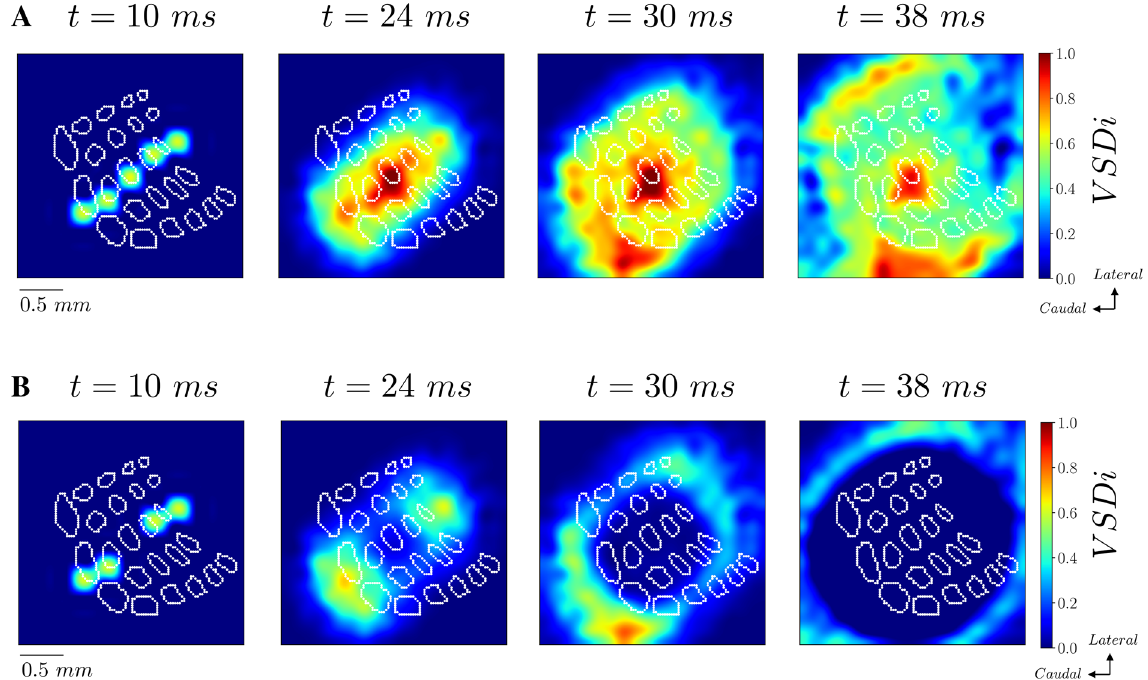
Figure 8. Model prediction of cortical activity evoked by stimulation of the entire C row. (A) VSD activity in response to stimulation of the entire C row inferred from the proposed model. ( B) Difference between VSDi activity in response to the activation of the entire C row (panel A ) and the activation of only the C2 whisker (Fig.